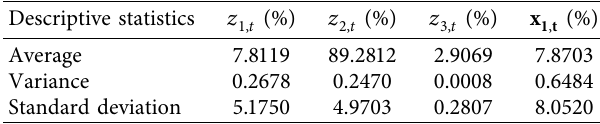
, z , and z 1 ,t 2 ,t 3 ,t